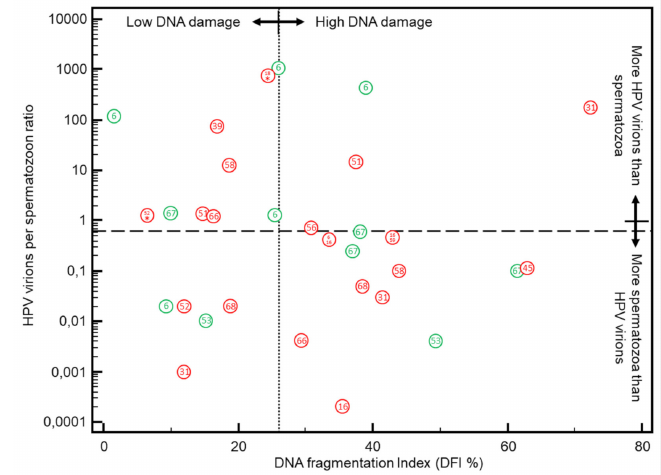
Figure 2. DNA fragmentation index (DFI%) versus HPV virions/spermatozoon ratio in neat sperm used for IUI. Dotted line = DFI cutoff (26%) above which no CP were observed with IUI (current study); Dashed line = the HPV virion per spermatozoon ratio cutoff (0.66) above which no CP were achieved with IUI (8); Green circles = low risk HPV types, Red circles = high risk HPV types. The number in the circle denotes the HPV type. 18* = multiple infection with HPV types 18, 6 and 59; 52* = multiple infection with HPV types 52, 53, 56 and 66. HPV types 6, 11, 16, 18, 31, 33, 35, 39, 45, 51, 52, 53, 56, 58, 59, 67 and 68 were quantified with real-time